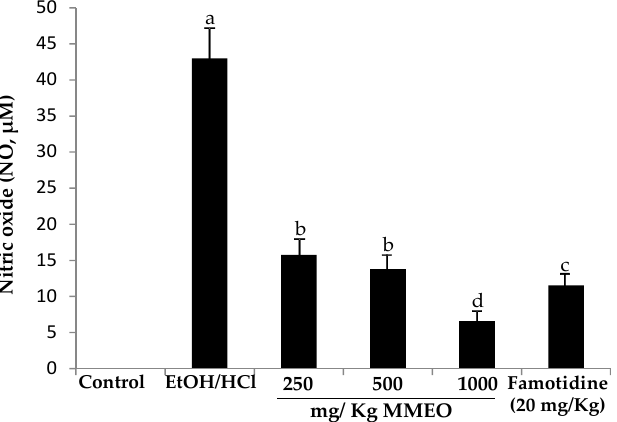
Figure 5. The effect of oral pre-treatment of ulcerated rat with microencapsulated M. communis essential oil (250, 500 and 1000 mg/kg MMEO) and famotidine, on nitric oxide (NO) production in gastric homogenate. Values are the means of three replicates and standard deviation. Values with different superscripts (a, b, c and d) are significantly different at p < 0.05.